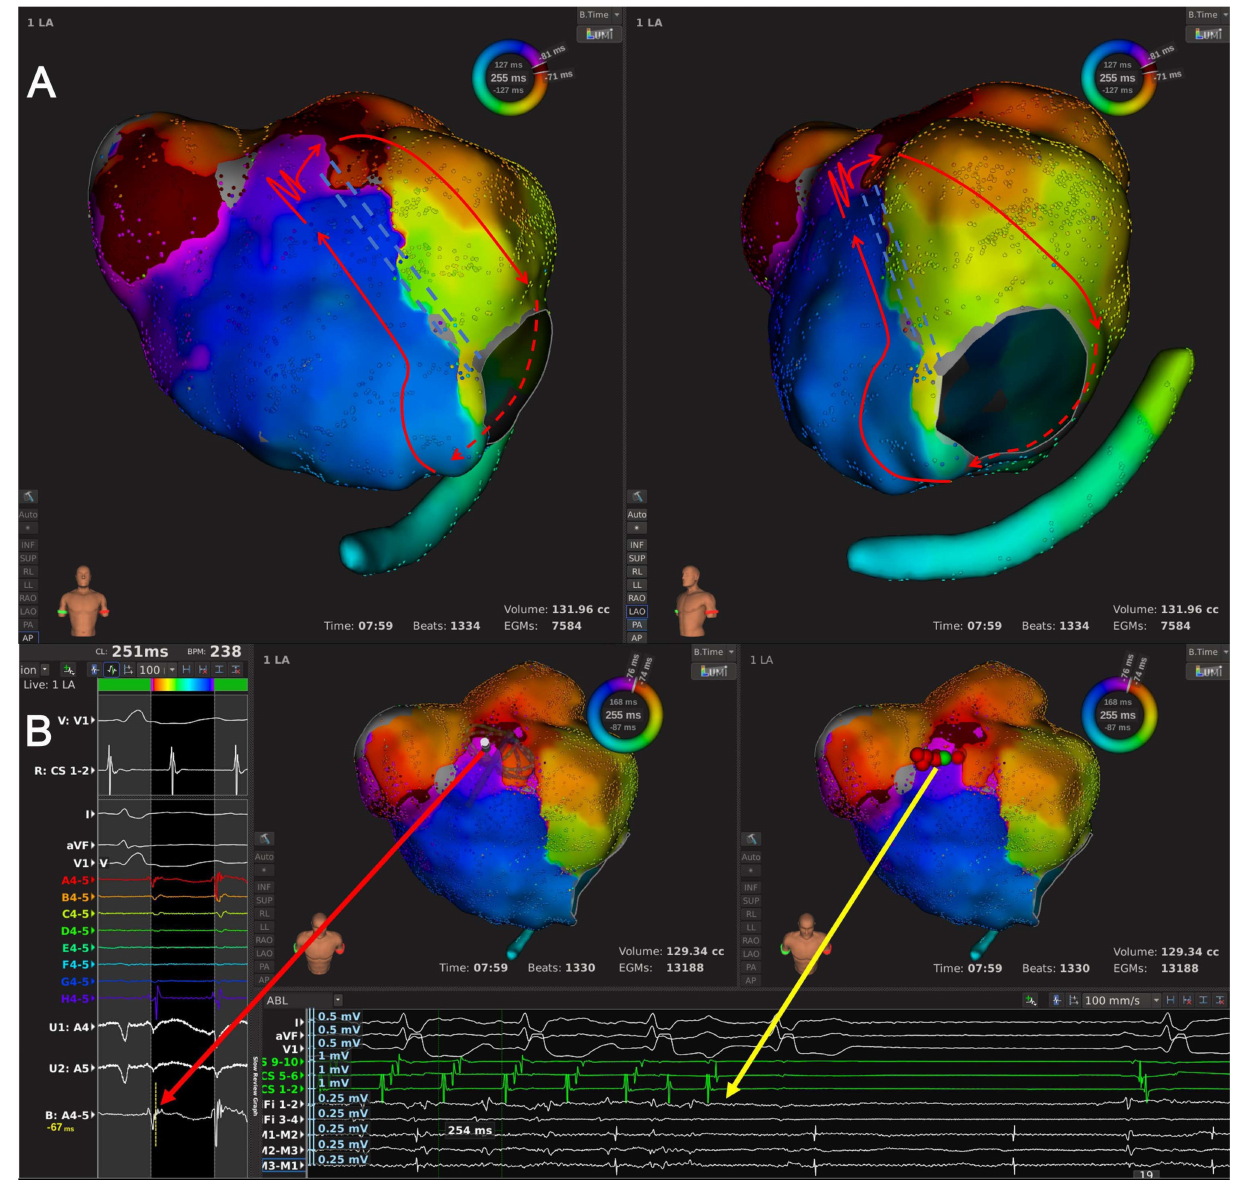
Figure 2. The high-density mapping of a Type 1.1 AT. ( A ) Activation map of a Type 1.1 AT from the anteroposterior view (left) and the left-anterior oblique view (right). The LA high-density mapping identified one LAAW block line stretching from the right superior pulmonary vein (RSPV) to the MVA, with a conduction gap near the RSPV end. The wavefront of AT ran along the LAAW line upwards in LA septum to jump across the LAAW gap, then ran toward MI and around the MVA clockwise, and returned to LA septum. The arrowed red lines indicated the AT circuit; the dashed red line indicated the AT circuit behind the atrial structure; the jagged red line indicated the wavefront passing the slow conduction area; the double-dashed blue line indicated the LAAW block of line. ( B ) Local map potentials of the LAAW gap during AT (left) and at the moment of AT termination (bottom). The red dots indicated the ablation points; the green dot indicated the termination site; the arrowed red and yellow lines indicated the local potentials during AT and at the moment of AT termination,